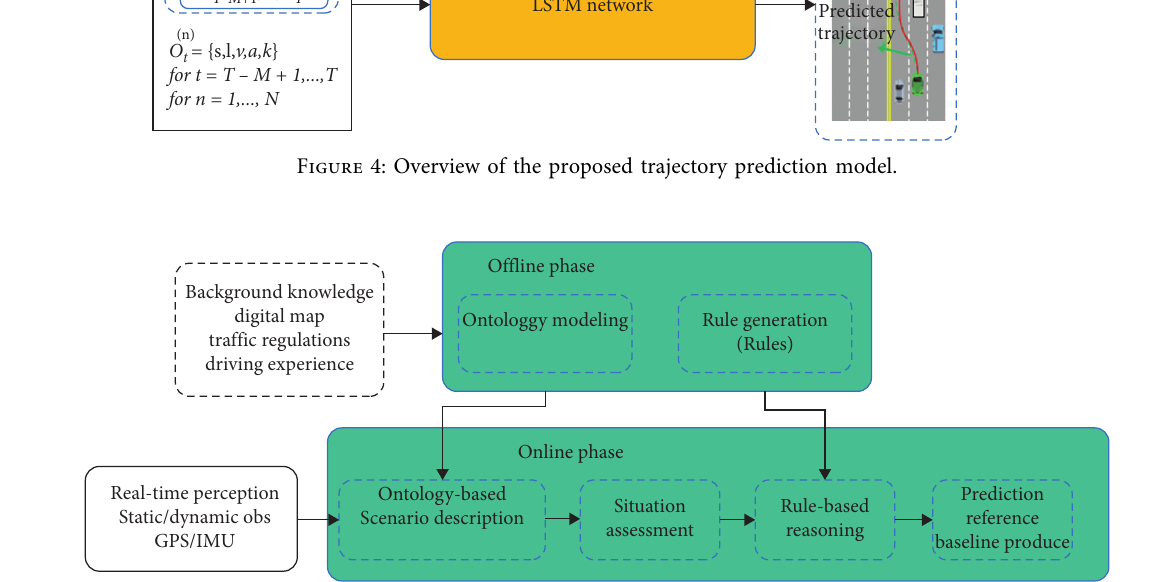
Figure 5: The architecture of the proposed prediction reference baseline determination